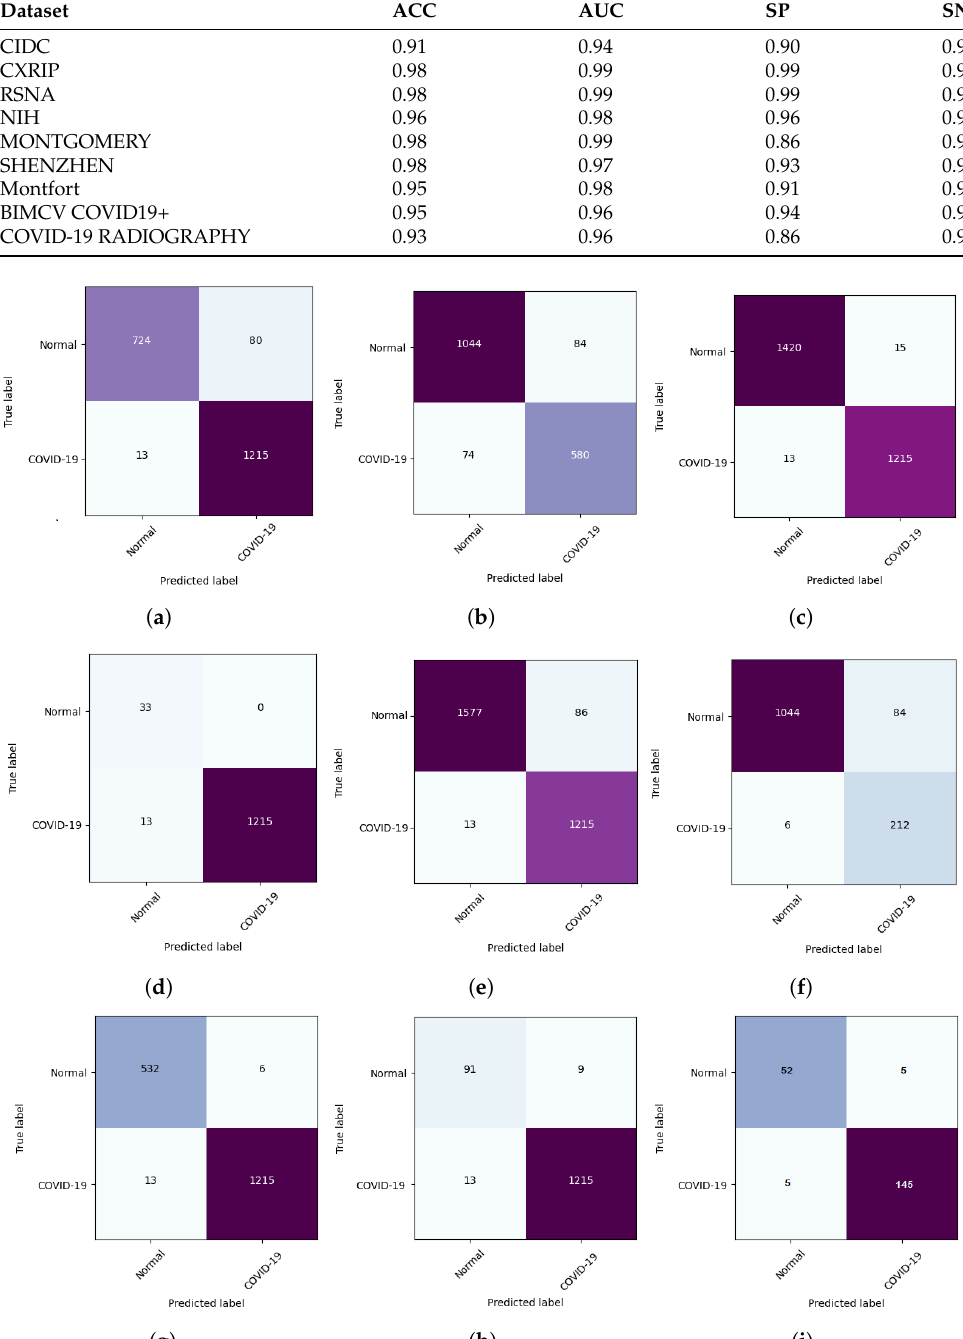
Table 5. Performance measures of DeepCCXR-Bin for COVID-19 detection in nine datasets.